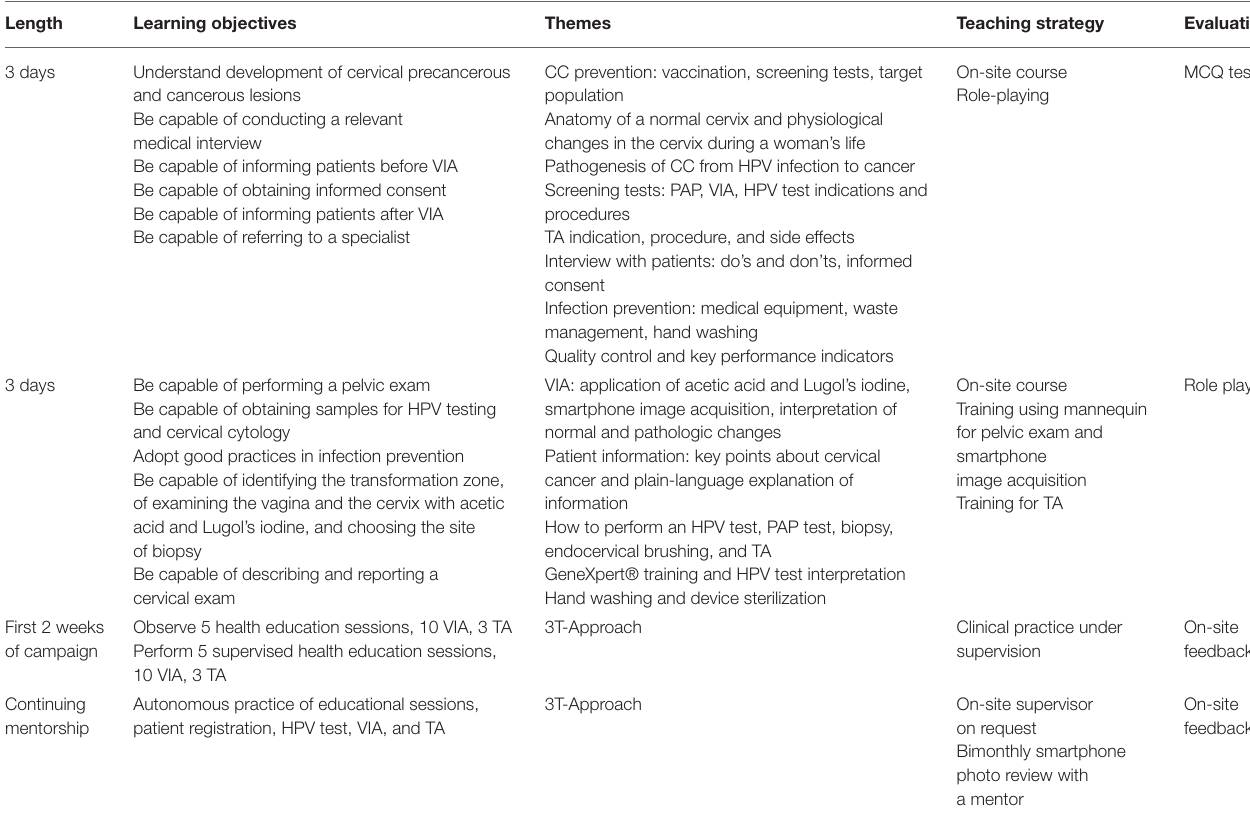
TABLE 1 | Components of frontline provider training using the 3T-approach.